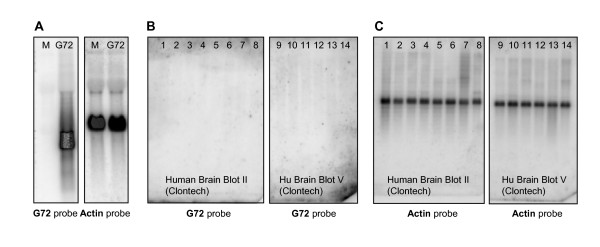
Investigation of G72 expression by northern analysis. (A) G72 and β-actin probes were validated using total RNA isolated from mock-transfected HEK-293 cells (M) or cells expressing His-G72 (G72). A strong signal for G72 was only observed in cells expressing His-G72. (B) Using a G72-specific, radioactive probe, no G72 signal was detected on Clontech poly A+ RNA Northern blots. The following brain regions were represented: Human Brain Blot II: 1, putamen. 2, temporal lobe. 3, frontal lobe. 4, occipital pole. 5, spinal cord. 6, medulla. 7, cerebral cortex. 8, cerebellum. Human Brain blot V: 9, thalamus. 10, whole brain. 11, hippocampus. 12, corpus callosum. 13, caudate nucleus. 14, amygdala. (C) Following G72-probing, human brain blots II and V were stripped and reprobed with a β-actin-specific probe in order to ensure RNA integrity and equal loading. Signal strength was similar in all lanes.